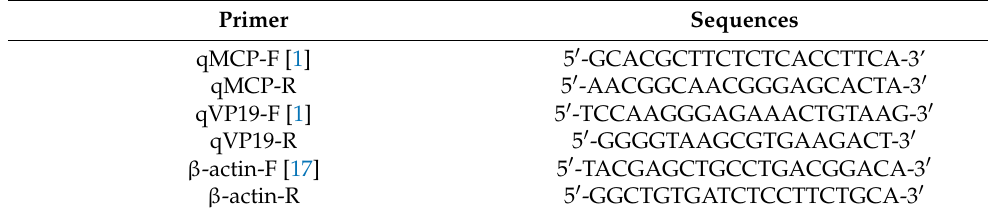
Table 1. Primers used to detect SGIV infection with